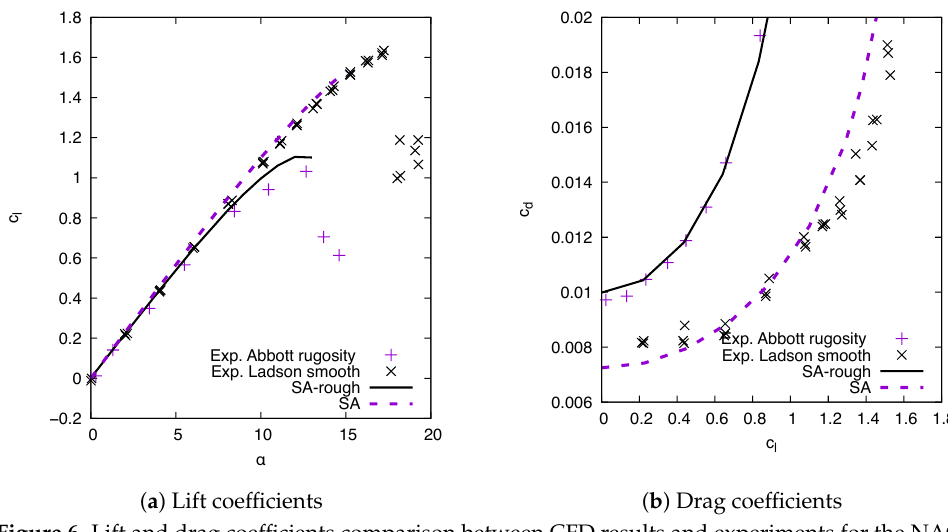
Figure 6. Lift and drag coefficients comparison between CFD results and experiments for the NACA 0012 with a leading edge roughness at Re = 6 × 10 6